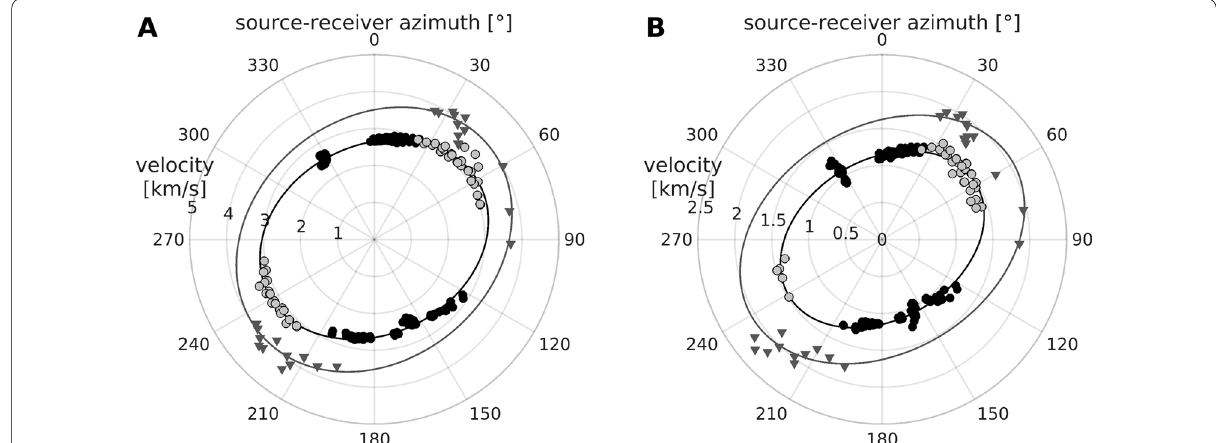
Fig. 4 Scatter plot of the anisotropic characterization in the horizontal plane starting from north ( 0 ◦ ). The apparent P-wave ( A ) and S-wave ( B ) velocities were grouped depending on their ray paths: gray triangles—propagation within the carbonate-rich sandy facies and black/lightgray dots—propagation within the shaly facies. The black dots indicate ray paths from and to the upper part of the pilot survey (north of the main fault) through the shaly facies. They are used to increase the azimuthal coverage. Shots parallel to the tunnel wall within the EDZ were excluded. The shown anisotropy ellipses were calculated for the shaly (black) and the carbonate-rich sandy facies